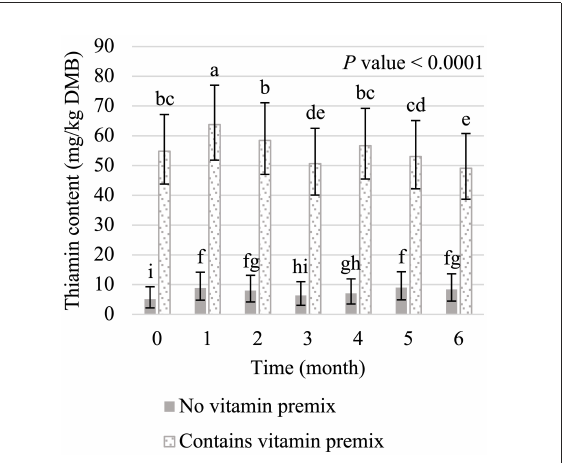
FIGURE5 Interaction of vitamin premix inclusion and time on dry matter basis (DMB) thiamin content (average with 95% confidence interval) of canned cat food stored in a commercial warehouse for 6 months. a − i Means without a common superscript are different ( P <